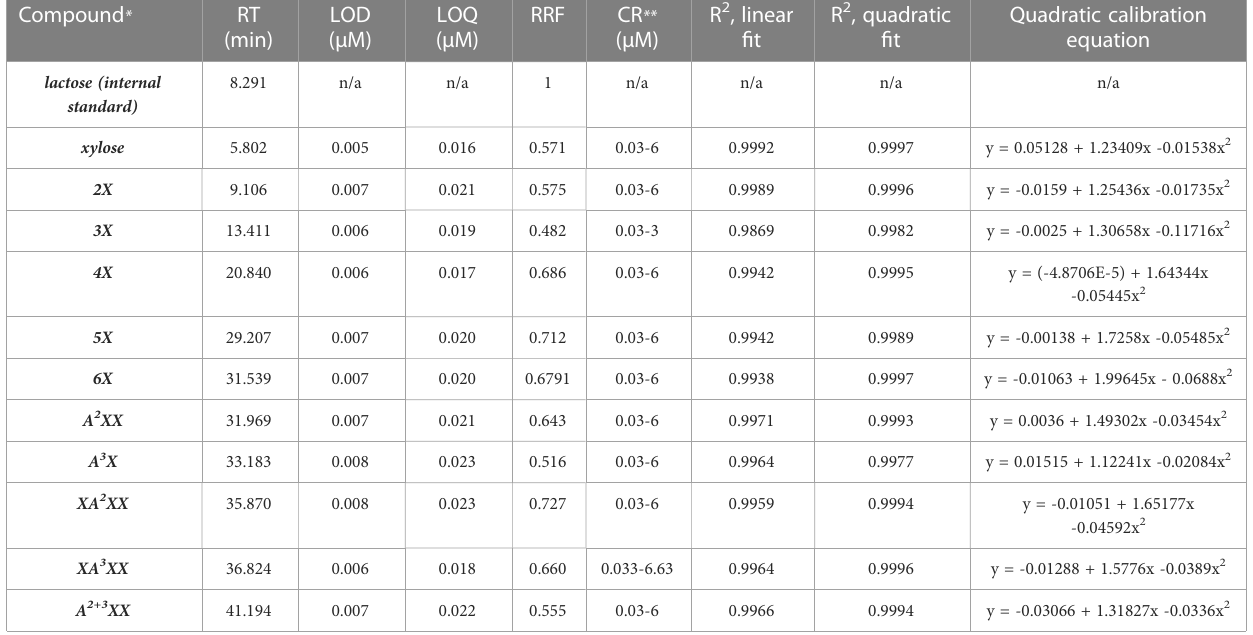
* Please refer to Figure 1 for chemical structures corresponding to standard compounds ’ abbreviations. **Range corresponds to the tested working concentration range. CR, Concentration range; LOD, limit of detection; LOQ, limit of quanti fi cation; RRF, relative response factor; RT, retention